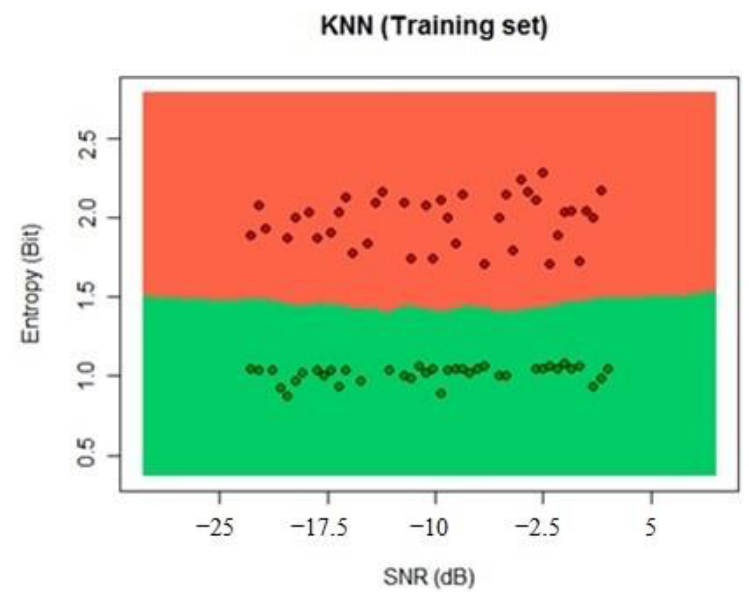
Figure 16. KNN training process classification.